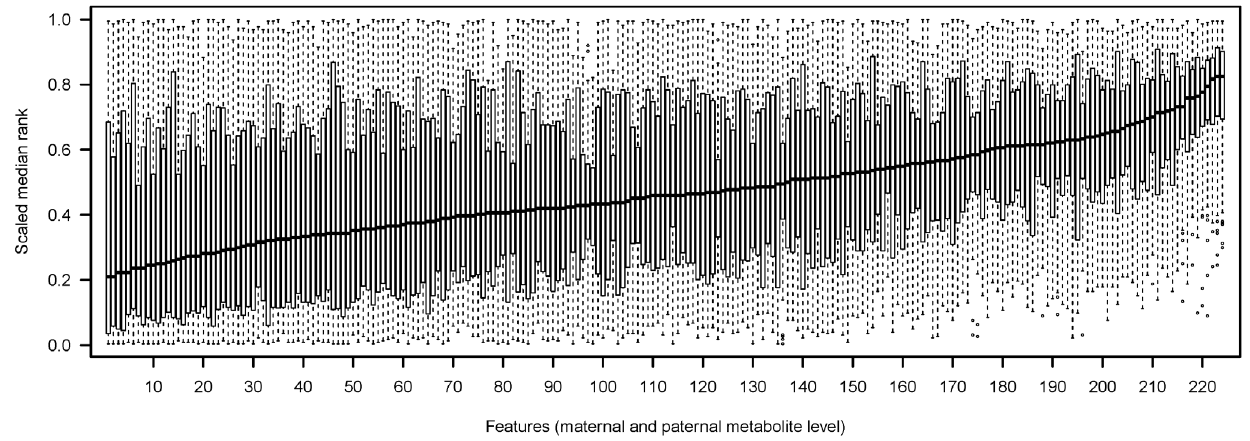
Figure 2. Ranking of the parental features. Parental metabolite levels (224 features in total) are used to predict the observed class labels of 54 hybrid metabolites. In each prediction model all features can be ranked according to their weights. The ranks are scaled between 0 and 1 by dividing by the total feature number. The scaled median rank distribution of a feature, i.e. the individual boxes in the plot, then gives an estimate regarding the importance of the absolute parental level of the respective metabolite on the heterosis pattern of all hybrid metabolites.